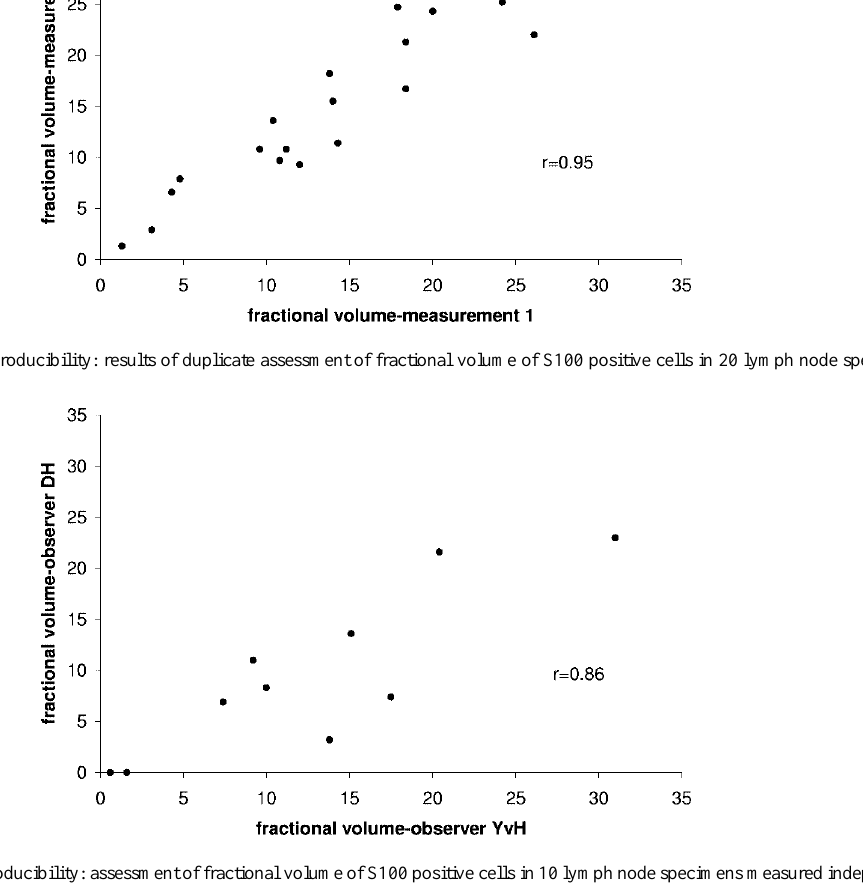
Fig. 5. Inter-observer reproducibility: assessment of fractional volume of S100 positive cells in 10 lymph node specimens measured independently by two